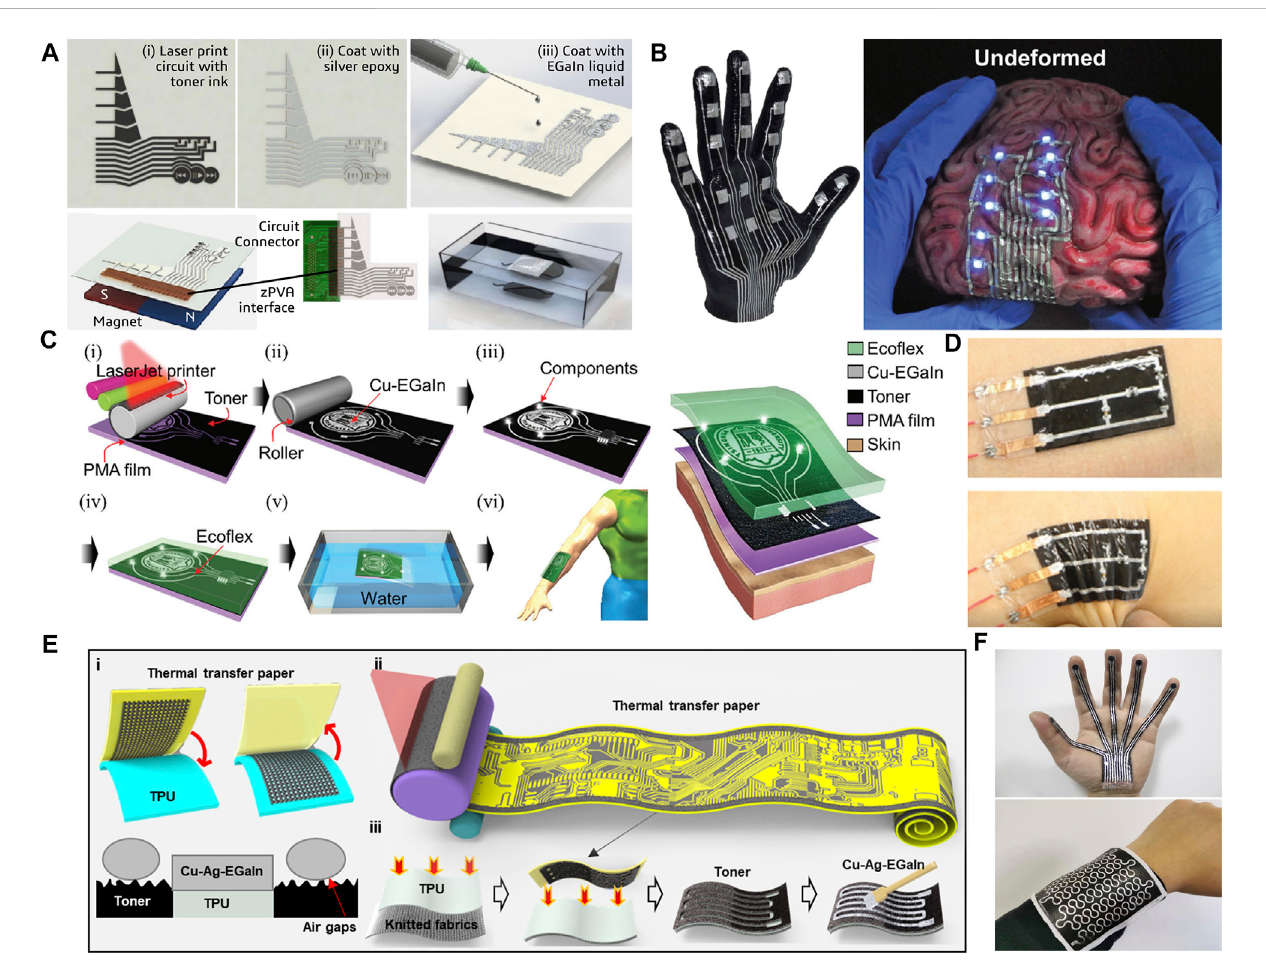
Fast printing method based on transfer printing substrate. (A) Fabrication steps including printing, interfacing with microelectronic chips or external circuits, and hydroprinting (Lopes et al., 2018). Copyright@2018, ACS (B) Example printed on a 3D printed hand model (Lopes et al., 2018); Copyright@2018, ACS Functioning LEDs on asoftbrain-shaped toy(Tavakoli etal., 2018). Copyright@2018,Wiley (C) Fabrication ofstretchable e-skin and structural diagram of the Cu – EGaIn enabled e-skin (Guo et al., 2020). Copyright@2020, RSC (D) . The temperature monitoring circuit transferred to human skin (Guo et